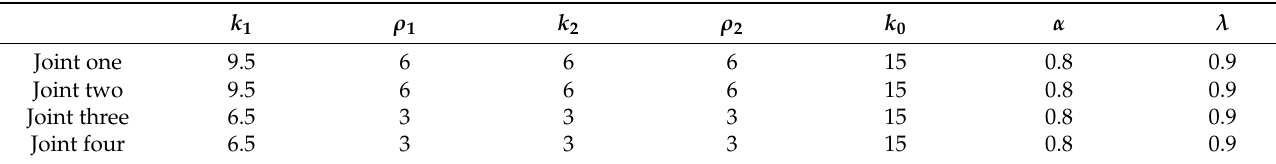
Table 11. Parameters of FONTSM-STA and FONTSM control.